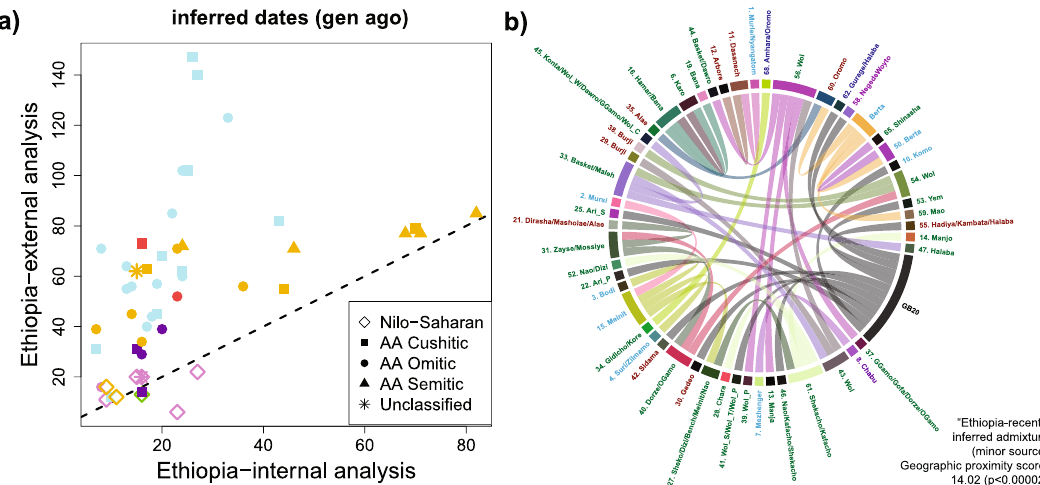
Fig. 4 Evidence of recent intermixing among nearby Ethiopian groups. a GLOBETROTTER-inferred dates (generations from present) for each Ethiopian cluster inferred to have a single date of admixture under each of the “ Ethiopia-external ” and “ Ethiopia-internal ” analyses. Inferred dates typically are more recent under the latter, indicating this analysis is picking up relatively more recent intermixing among sources represented by present-day Ethiopian clusters. Colours match those in Fig. 3 for these clusters. b GLOBETROTTER-inferred ancestry sources under the “ Ethiopia-internal ” analysis. Each Ethiopian cluster X , also including Mota, has a corresponding colour (outer circle). Lines of this colour emerging from X indicate that X was inferred as the best surrogate for the admixing source contributing the minority of ancestry to each other cluster it connects with. The thickness of lines is proportional to the contributing proportion. Ethiopian clusters, with labels coloured by language category according to Fig. 1a, are ordered by the fi rst component of a principal components analysis applied to the geographic distance matrix between groups, i.e., so that geographically close groups are next to each other. The “ geographic proximity score ” gives the average ordinal distance between an admixture target and the surrogate that best represents the source contributing a minority of the admixture, with the one-sided p value testing the null hypothesis that admixture occurs randomly between groups (i.e., independent of the geographic distance between them) based on permuting cluster labels around the